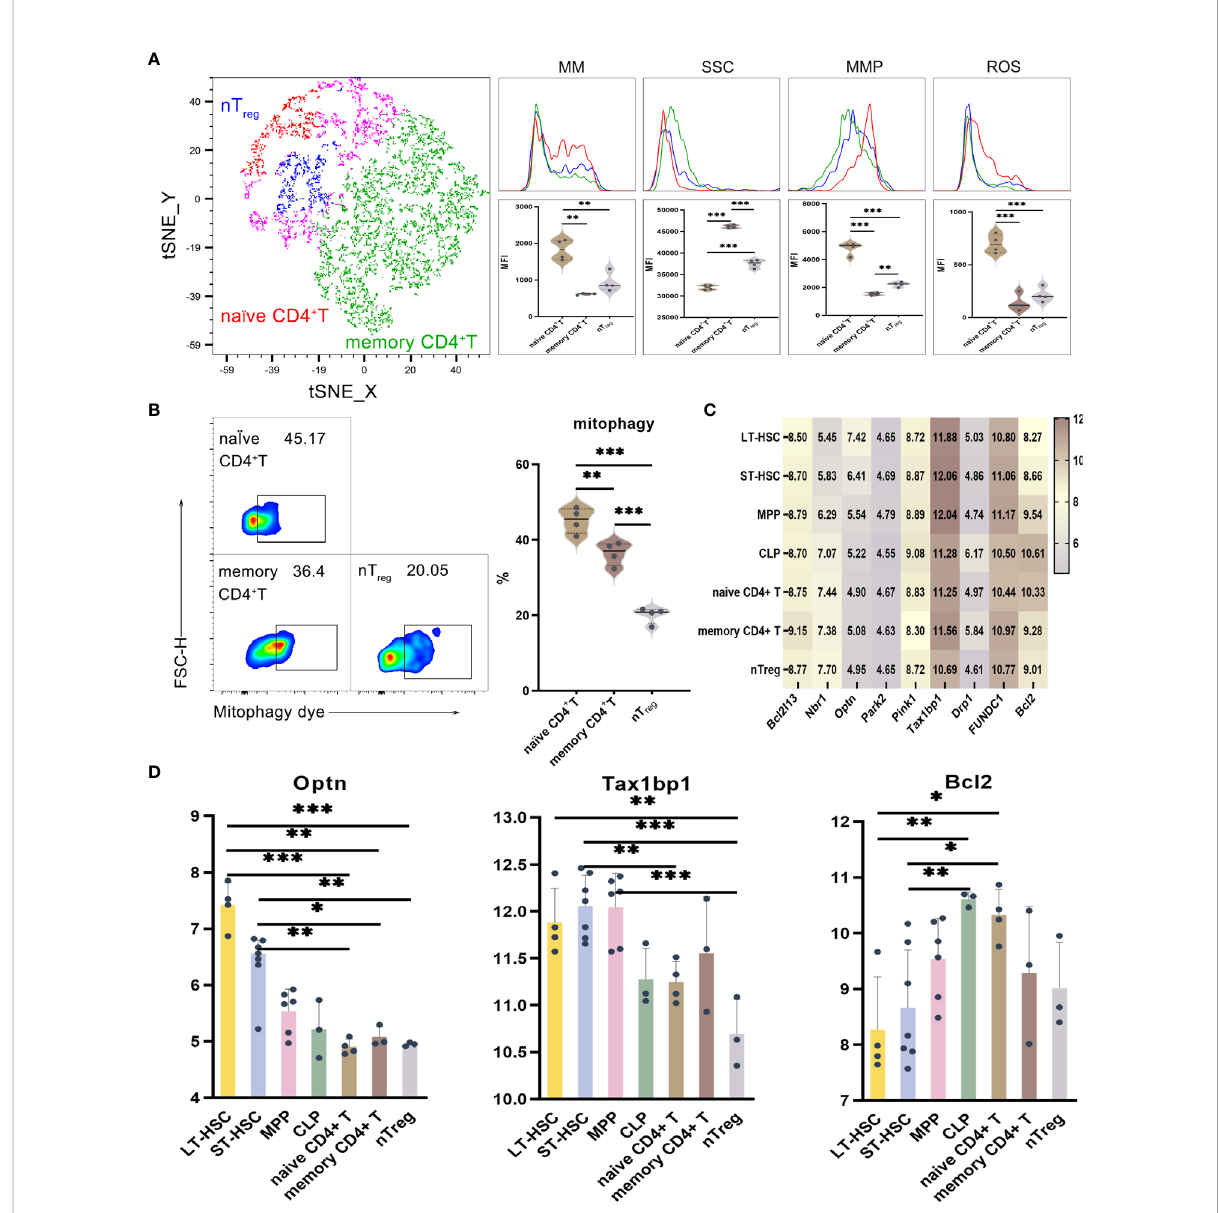
FIGURE 4 (A) t-SNE, MM, SSC, MMP and ROS in nT reg , memory CD4 + T and naive CD4 + T cells (B) Mitophagy in memory CD4 + T, naive CD4 + T and nT reg cells (C) Heat map for the expression levels of autophagy-related genes in CD4 + T cell at different differentiation and activation stages (D) Statistics for the expression level of autophagy-related genes. Normally-distributed data are presented as the mean ± SD, while non-normally- distributed ones are presented as the median with the interquartile range. One-way ANOVA or the Kruskal – Wallis test was used for comparisons and determining the P values. * P <0.05, ** P <0.01, *** P